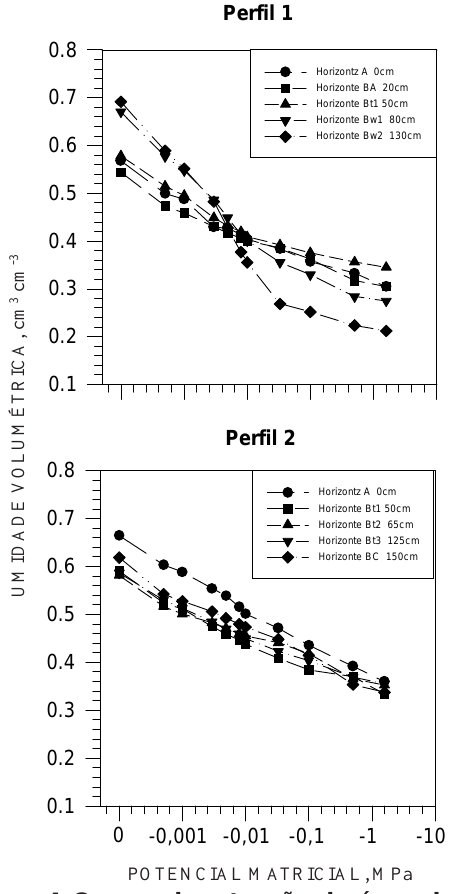
Figura 4. Curvas de retenção da água dos perfis estudados. As curvas foram feitas utilizando o log do potencial matricial em MPa.